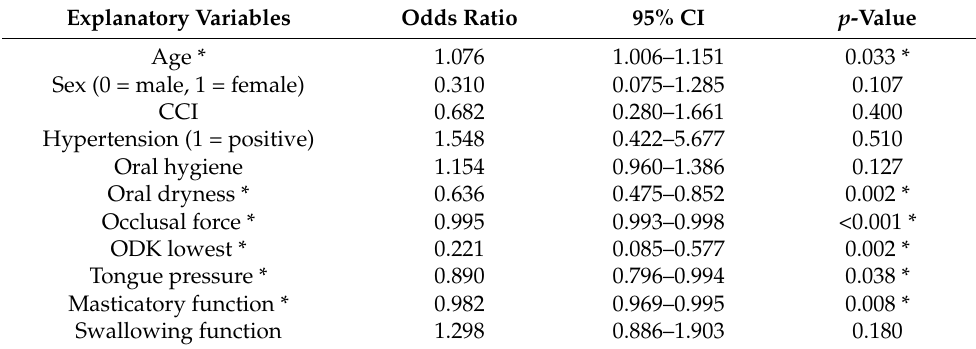
Table 2. Logistic regression analysis with oral hypofunction as the objective